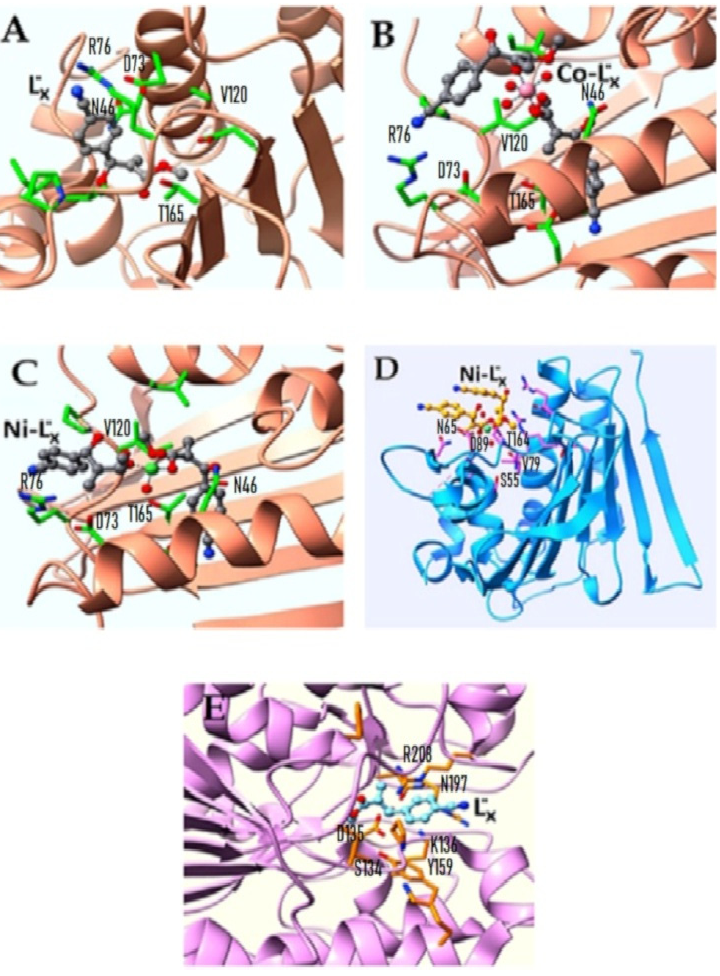
Figure 10. The Binding Conformations of Ligand and Corresponding Metal Complexes Active against ( A – C ) E. coli , ( D ) S. aureaus and ( E ) S. typhi